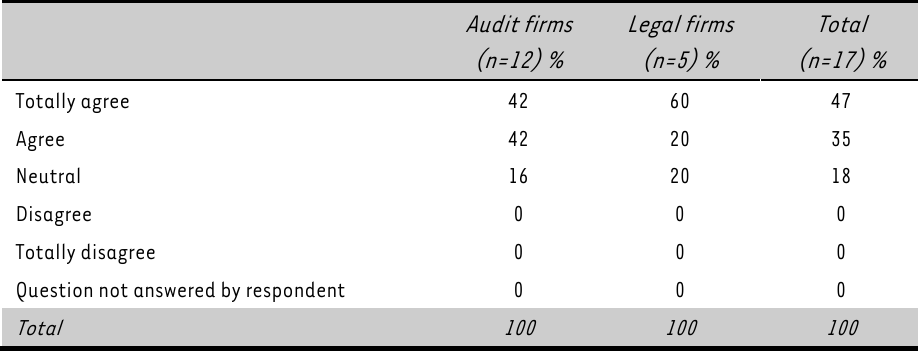
TABLE 7: Results of Question